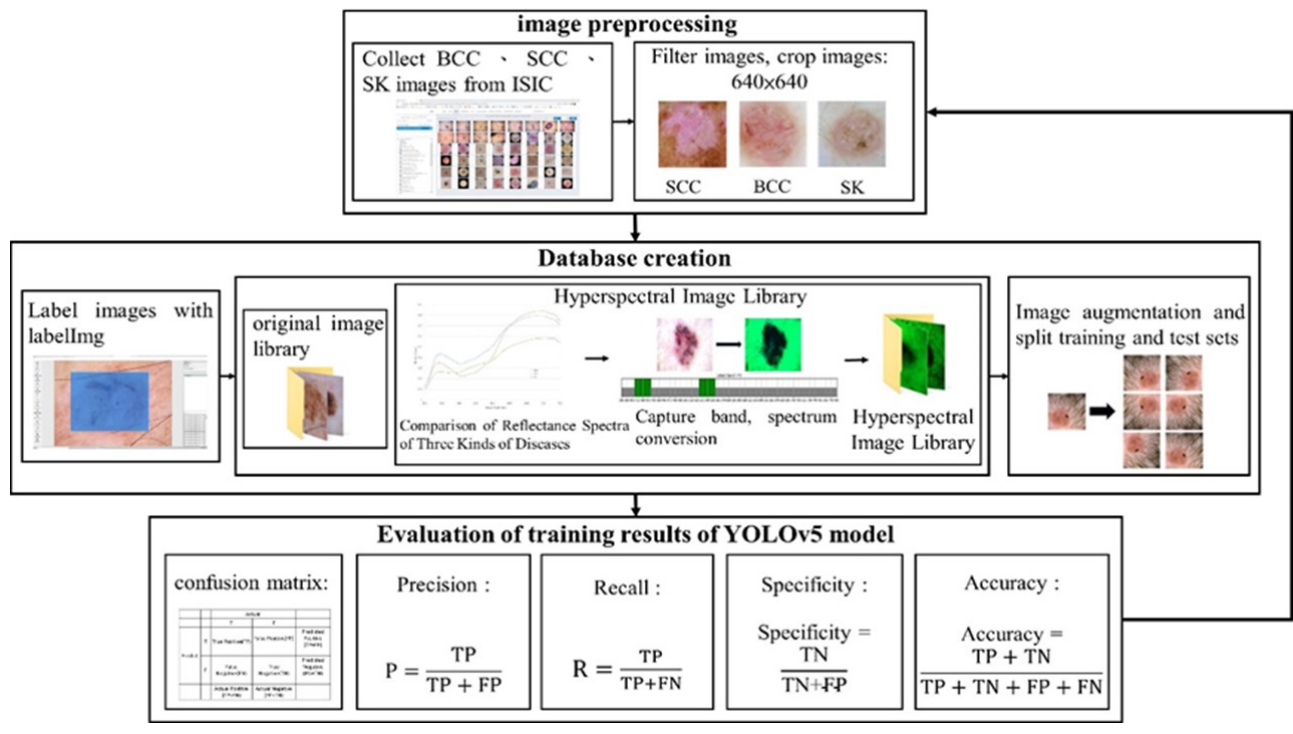
Figure 1. Overall experimental flow chart.